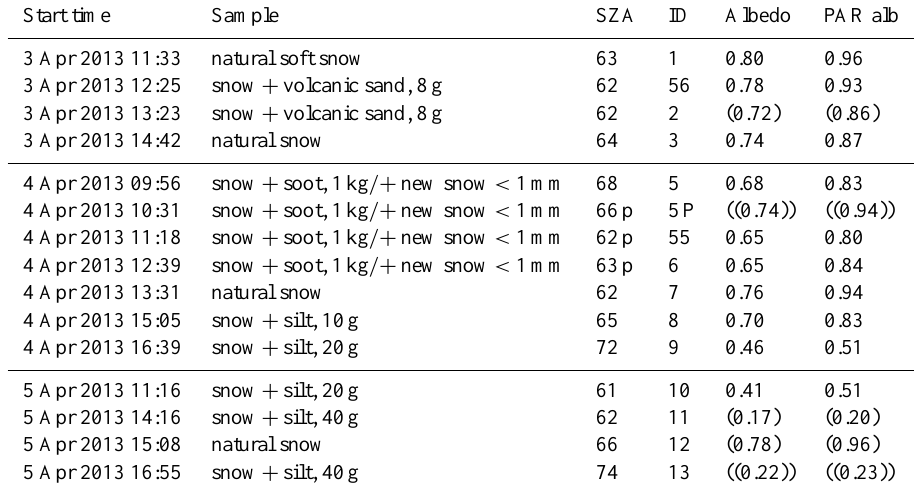
Table 1. List of the samples measured using FIGIFIGO during the SoS campaign at Sodankylä Airport. Numbers in parentheses are from unstable data; double parentheses denote very unstable data, due to increasing cloudiness. ID means the name by which the measurement is found in the data base, SZA is the solar zenith angle, and PAR alb is the albedo integrated over the photosynthetically active range.